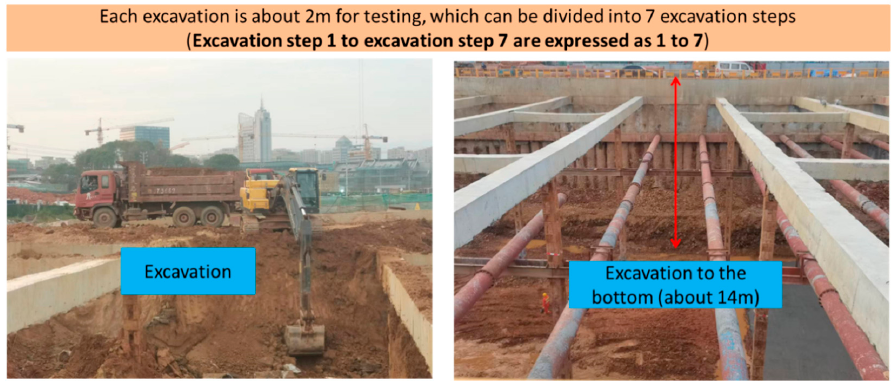
Figure 6. Excavation steps.